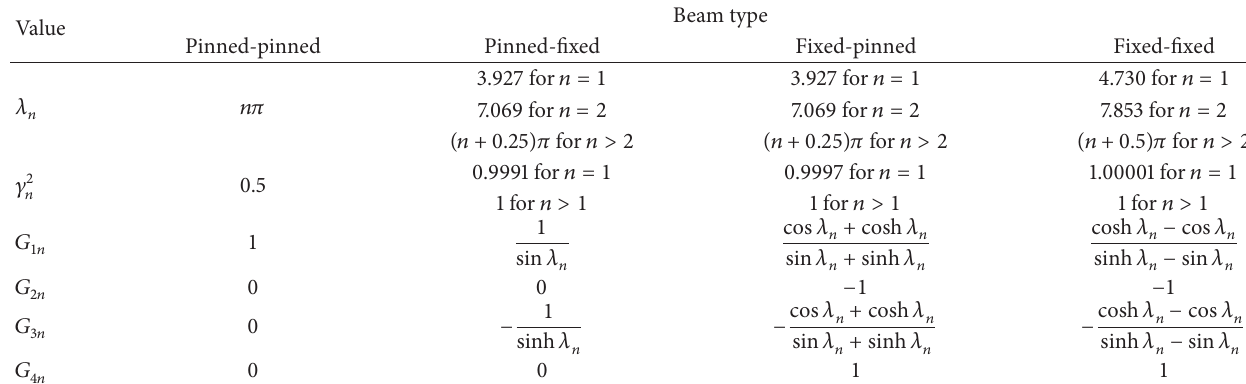
Table 1: Constants 𝐺 1𝑛 , 𝐺 2𝑛 , 𝐺 3𝑛 , 𝐺 4𝑛 , 𝛾 2 𝑛 and eigenvalues 𝜆 𝑛 for different types of